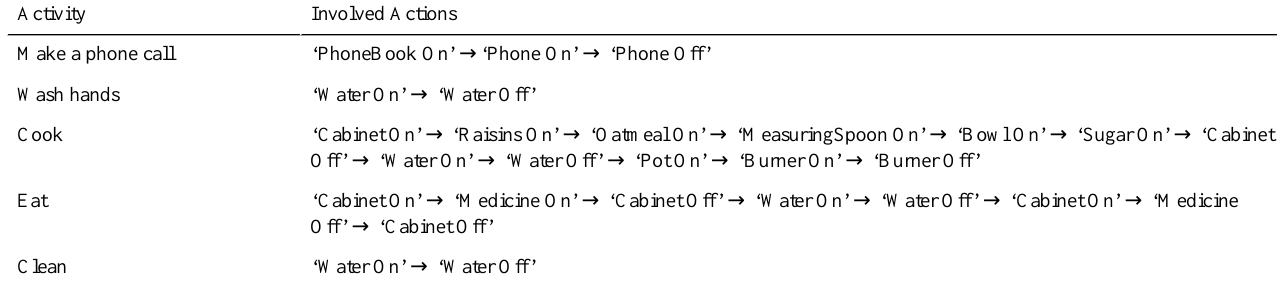
Table 1. Actions involved in each ADL.